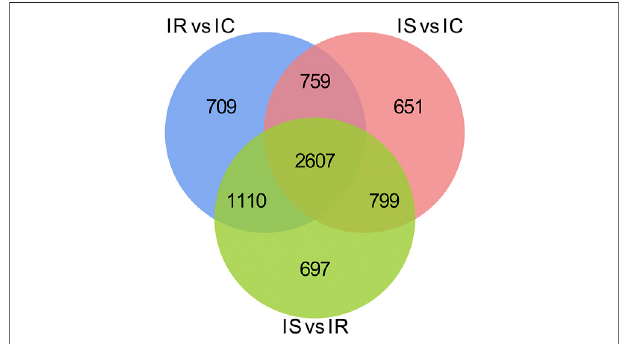
FIGURE5| VenndistributionofthedifferentiallymethylatedmRNAswith CGIs in the IR vs. IC, IS vs. IC, and IS vs. IR groups. GO and KEGG signaling pathway